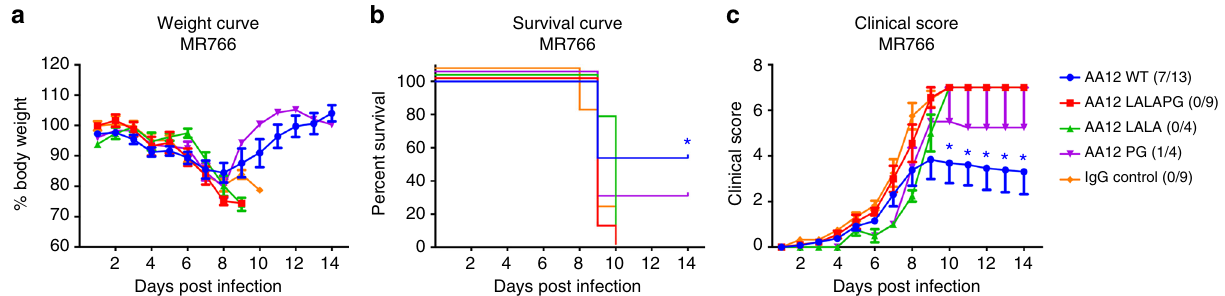
Fig. 6 NS1-speci fi c antibodies protect mice against lethal challenge in vivo in an Fc-dependent manner. a – c Groups of 4 – 13 male and female B6.129-Stat2 – / – mice were injected IP with 10 mg per kg of wildtype AA12, AA12 LALAPG, AA12 LALA, or AA12 PG Fc-variants before a challenge with 10 mLD 50 of ZIKV MR766. The mAb CR9114 against in fl uenza A virus was used as an IgG isotype control. Weight loss was monitored daily. Clinical scoring was conducted using the pre-de fi ned criteria with a maximum possible score of 7: impact on walking (1), unresponsiveness (1), left hind leg paralyzed (1), right hind leg paralyzed (1), left front leg paralyzed (1), and right front leg paralyzed (1). Deceased animals were awarded a score of 7. The ratios in the fi gures indicate the number of animals that survived challenge over total number of animals per group. Murine challenge studies were performed as three independent replicates with at least four mice per treatment group and data shown here were pooled. Statistical analyses were performed using the Mantel-Cox and Gehan-Breslow-Wilcoxon tests for the survival curves and a multiple t -test and the Holm-Sidak method for the weight curve and the clinical score. Signi fi cance (* p < 0.05) is indicated compared to IgG control. No signi fi cant differences between the groups were detected in